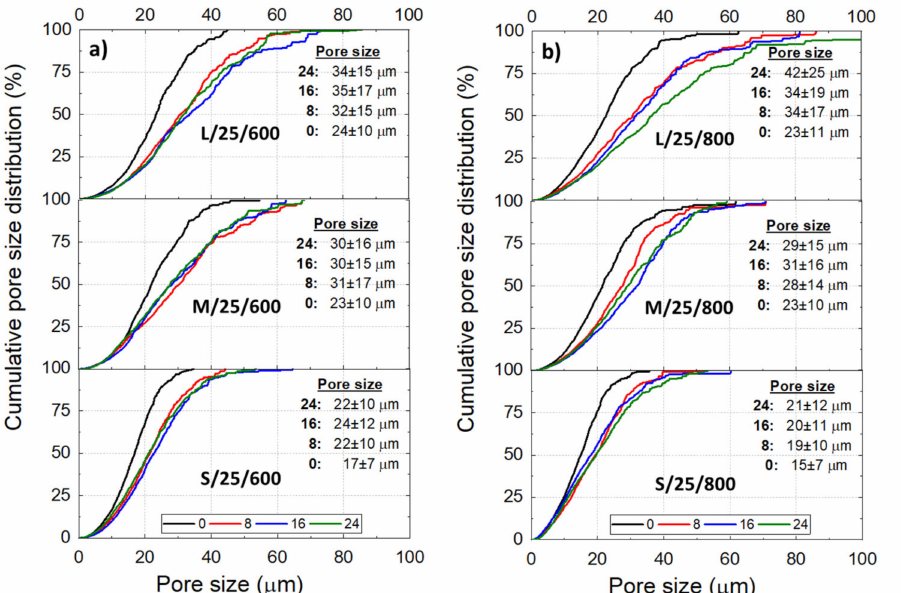
Figure 5. Cumulative pore size distribution of the Ni wicks freeze-casted at 25 ◦ C according to the initial sample height ( h = 0, 8, 16, and 24 mm), particle size range (L, M, and S), and the sintering